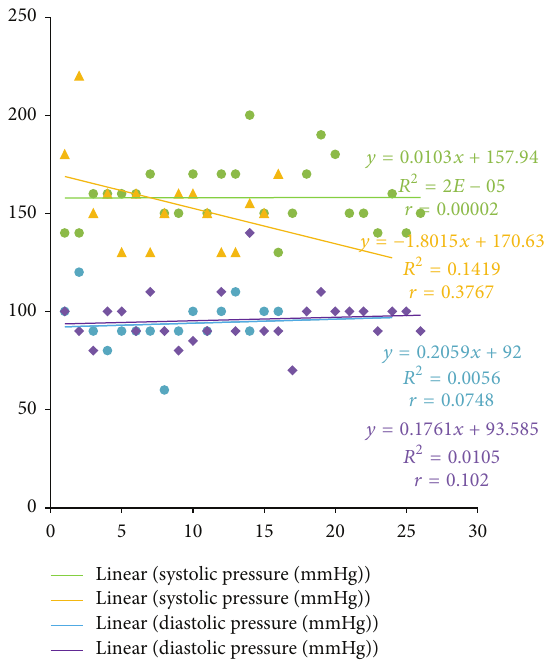
Figure 7: Correlation of systolic and diastolic blood pressure of hypertensive subjects across gender distribution. Purple lines and points: females. Blue line and points: males. Green line and points: females.Yellowlineandpoints:males.Numberofmalehypertensive subjects ( 𝑛 ) = 16. Number of female hypertensive subjects ( 𝑛 ) = 26.